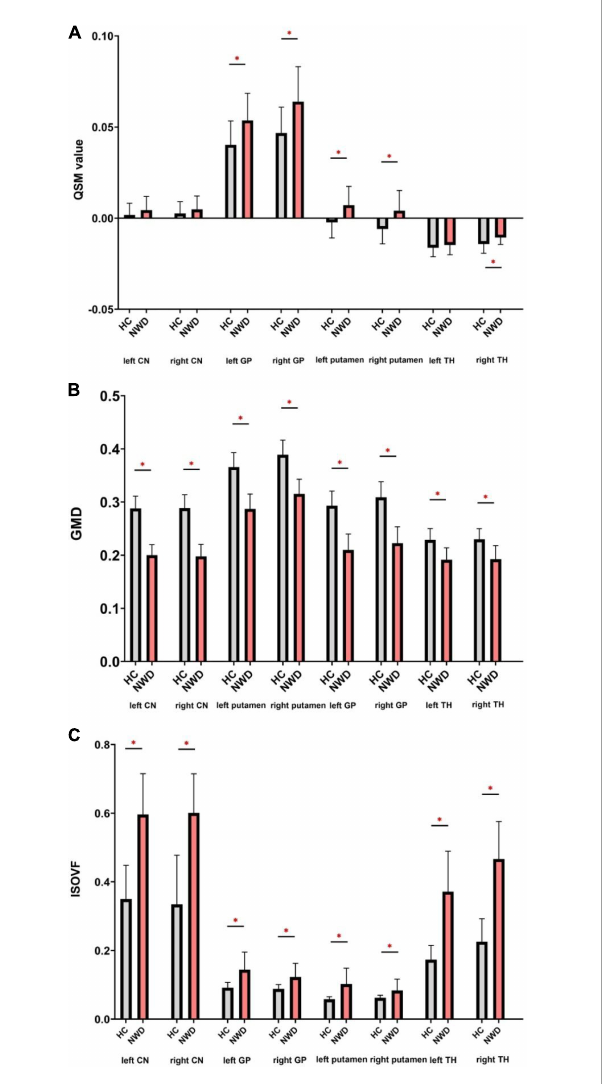
FIGURE2 Comparison of the QSM (A) , GMD (B) , and ISOVF (C) values between the WD patients and HCs. QSM, quantitative susceptibility mapping; GMD, gray matter density; ISOVF, isotropic volume fraction; CN, caudate nucleus; GP, globus pallidus; TH, thalamus. * P < 0.05, with FDR